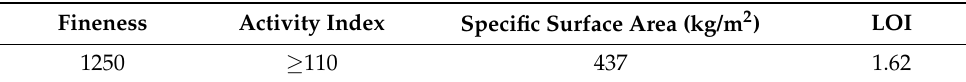
Table 2. Physical properties of metakaolin.